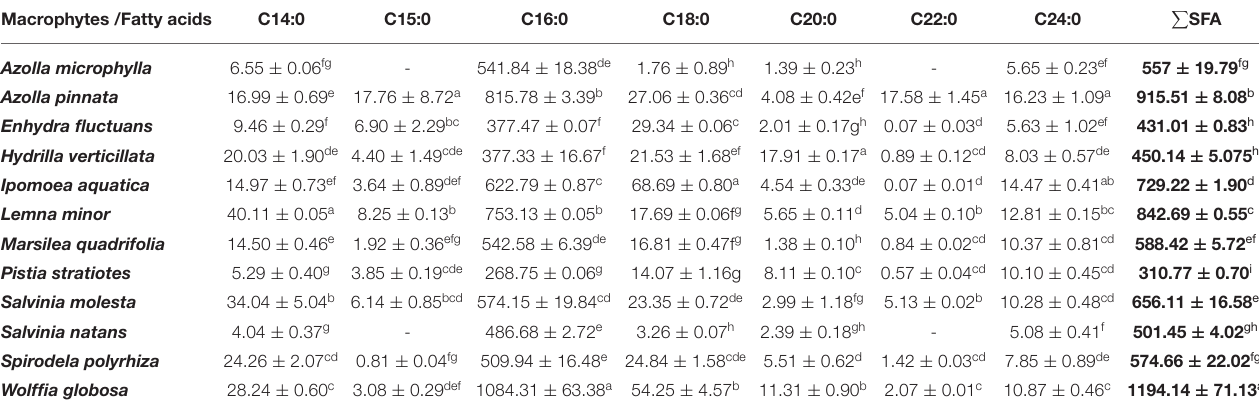
Values having the means (n = 3) in each row with different superscript are significantly (p < 0.05) different.